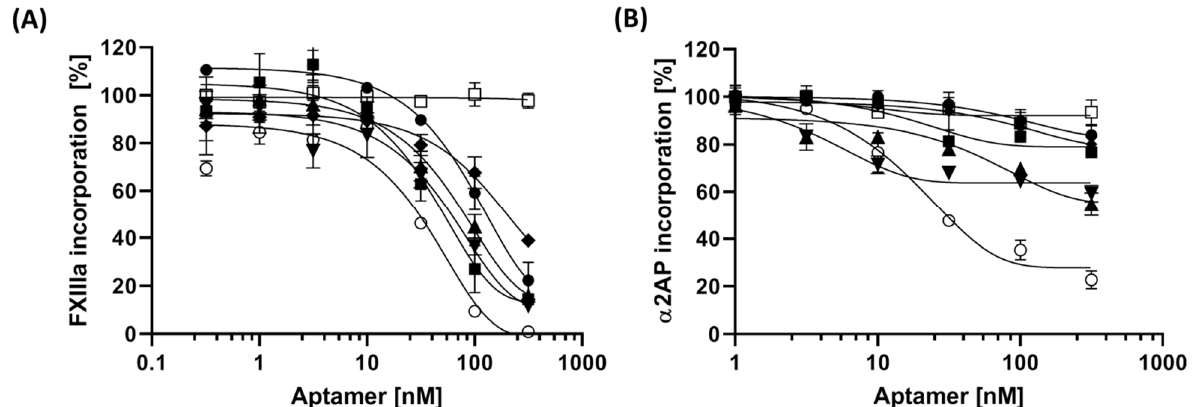
Figure 3. Aptamer binding reduced incorporation of FXIIIa and α 2-antiplasmin ( α 2AP) to fibrinogen. Retention of ( A ) FXIIIa or ( B ) α 2AP in fibrinogen coated microtiter plates in the presence of increasing concentrations of aptamers was detected using fluorogenic peptide substrate or a polyclonal antibody against α 2AP, respectively. All results are shown as means with standard deviations of triplicates. ● FA1, ■ FA2, ▲ FA3, ▼ FA6, ♦ FA8, ○ FA12, □ negative control sequence. Table 2. Key characteristics of FXIIIa aptamers.